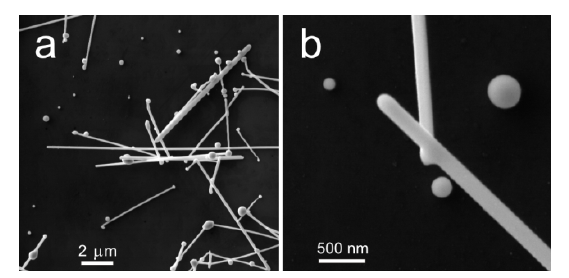
Figure 3: High resolution SEM images of Ag nanowires (diameter 120 nm) after pulsed laser annealing (a). Ag NPs of different size produced by laser annealing